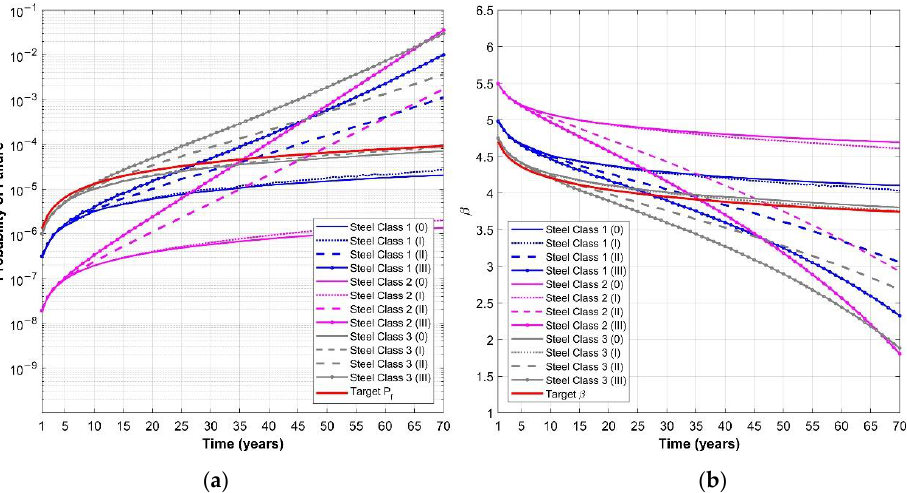
Figure 13. Time-dependent probability of failure ( a ) and reliability index β ( b ) for shopping buildings (concrete class 4)